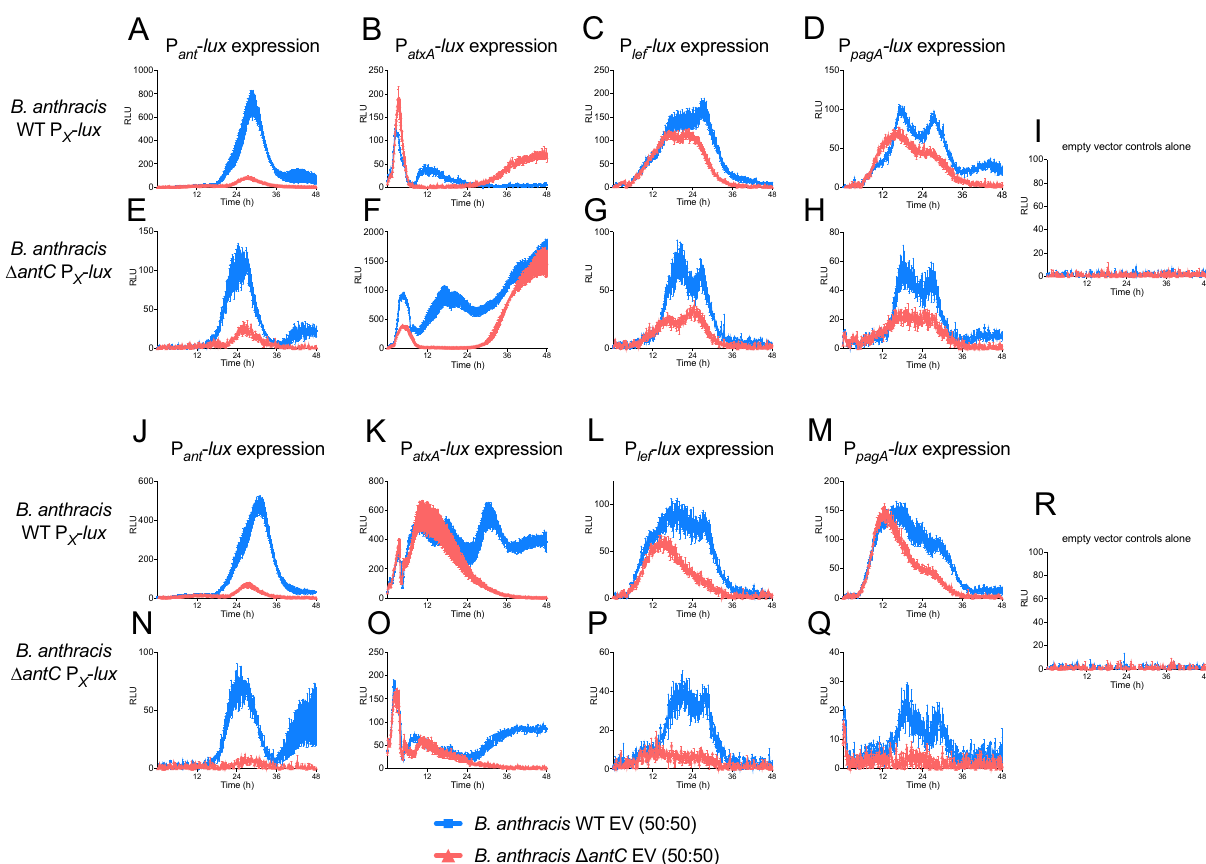
Figure 8. Co-culture with anthrose positive strains affects expression of virulence related and anthrose biosynthetic genes. Luminescent expression patterns of ( A ) Sterne WT P ant -lux , ( B ) Sterne WT P atxA -lux , ( C ) Sterne WT P lef - lux, ( D ) Sterne WT P pagA - lux, ( E ) Sterne Δ antC P ant -lux , ( F ) Sterne Δ antC P atxA -lux , ( G ) Sterne Δ antC P lef - lux, ( H ) Sterne Δ antC P pagA - lux when grown in BHI at a 50:50 mixture with Sterne WT EV strain (blue lines in each graph) or Sterne Δ antC EV strain (red lines in each graph). ( I ) Shows that pure cultures of either the Sterne WT EV strain or Sterne Δ antC EV strain are not luminescent. ( J–R ) are the same co-culture strains as ( A – I ) but were grown in